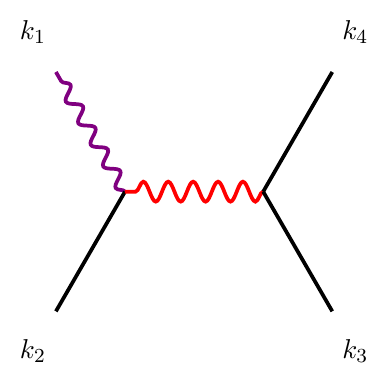
Figure 7 . psss amplitude due to exchange of a massive spinning particle.